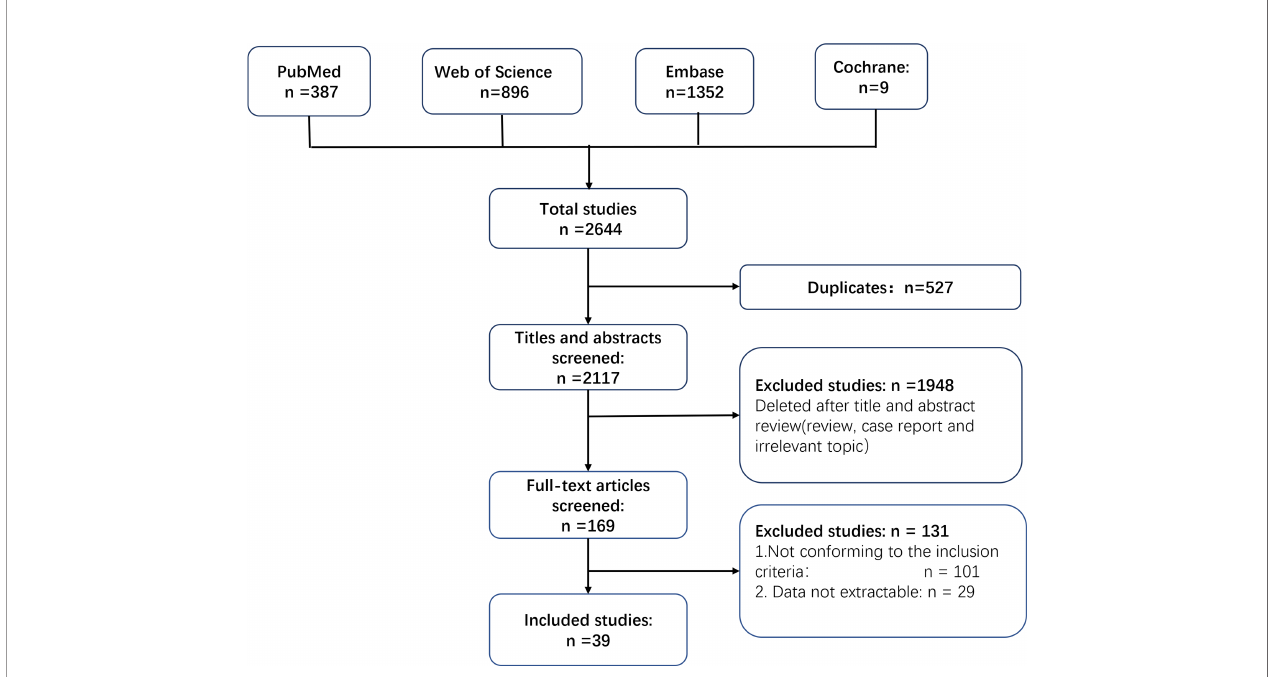
FIGURE 1 | Flow diagram of systemic review